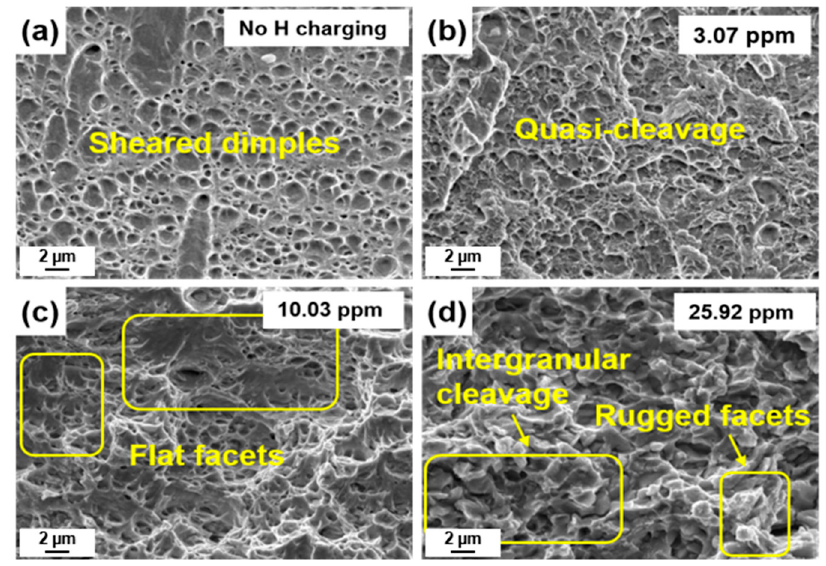
Figure 8. Fracture surfaces at the edge region of austenite-reverted-transformation annealed specimens undergone slow strain rate tensile until fracture. ( a ) No H-charged state; ( b ) H-charged for 2 h with 3.07 ppm; ( c ) H-charged for 8 h with 10.03 ppm. ( d ) H-charged for 24 h with 25.92 ppm.